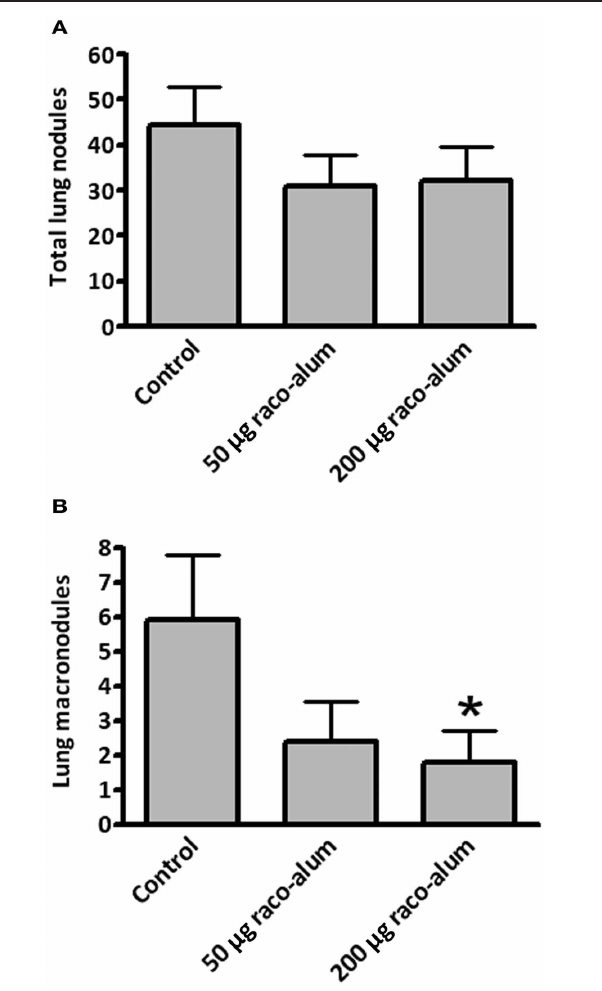
FIGURE 3 | Effect of exogenous incorporation of NeuGc on experimental lung tumor formation. 3LL cells were preincubated in vitro with purified NeuGc and then injected intravenously in mice, as described in “Materials and Methods.” (A) Flow cytometryc analysis of 3LL cells after preincubation with purified NeuGc, resulting in an increase of NeuGcGM3 ganglioside in cell membrane, as detected by the specific 14F7mAb. White and gray curves present results from control and NeuGc-preincubated cells, respectively. (B) Total lung tumor nodules experimentally formed by control or NeuGc-preincubated 3LL cells. (C) Experimental formation of lung macronodules ( > 2mm in diameter) by control or NeuGc-preincubated 3LL cells. Lung lesions are shown as mean ± SEM. ∗∗ p < 0 . 01 (unpaired t -test with Welch’s correction).